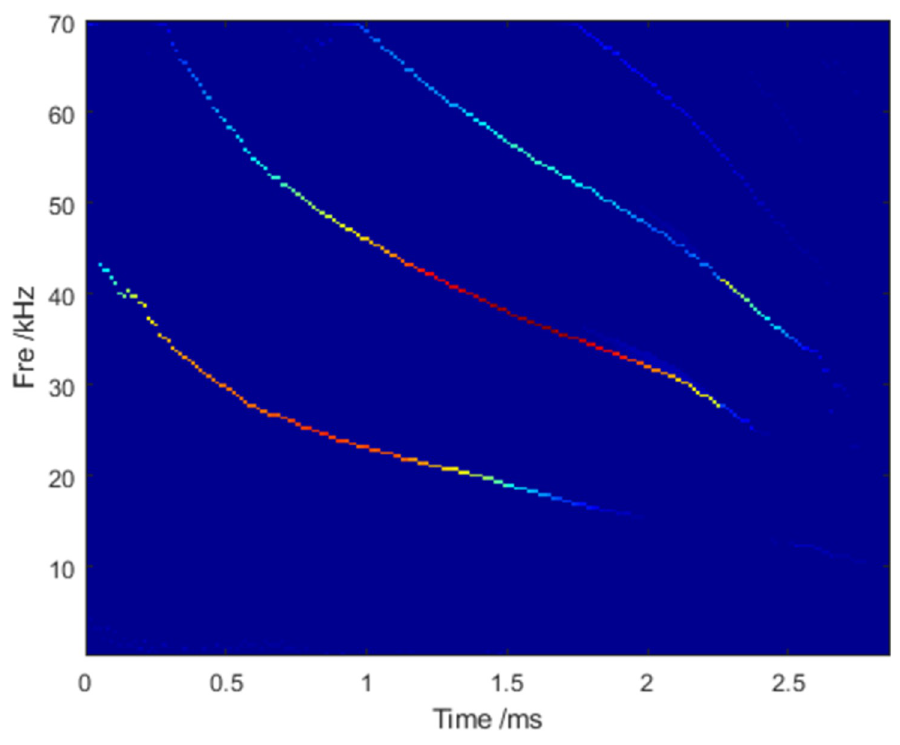
Fig 11. TFA results obtained by LMSBCT.